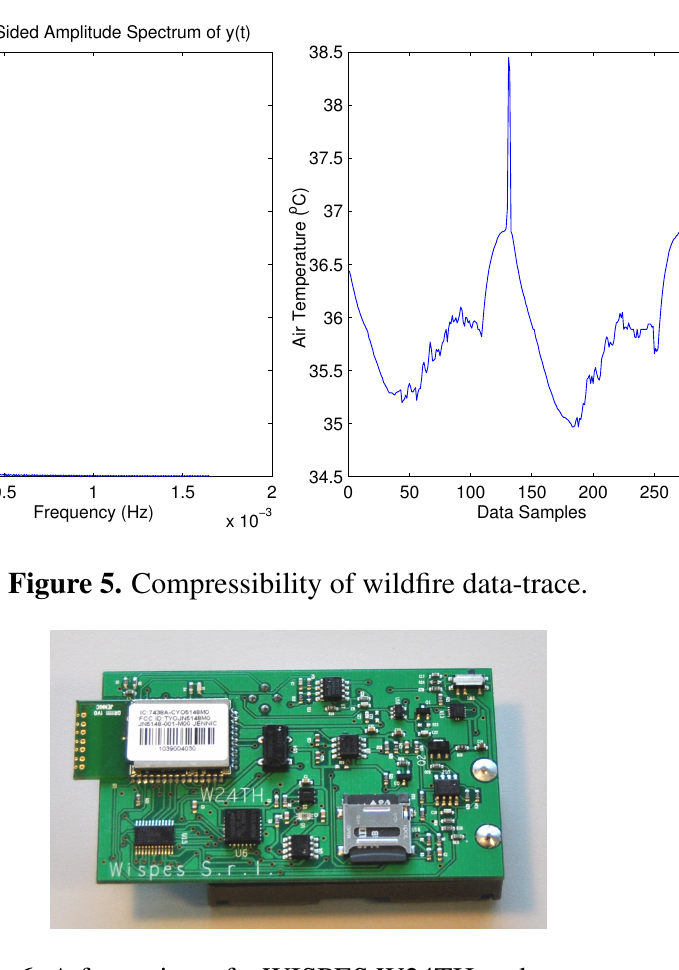
Figure 6. A front view of a WISPES W24TH node